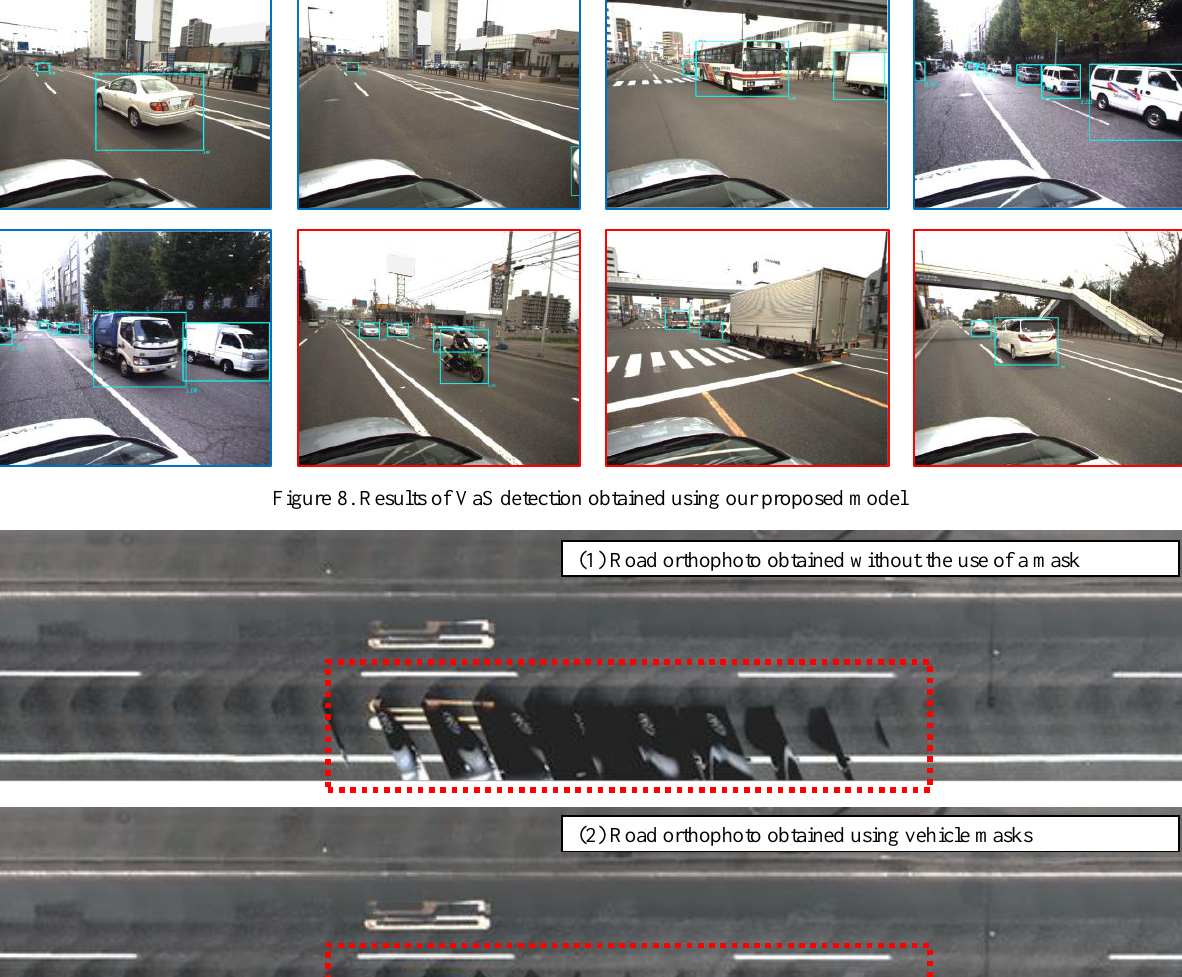
(3) Road orthophoto obtained using VaS masks